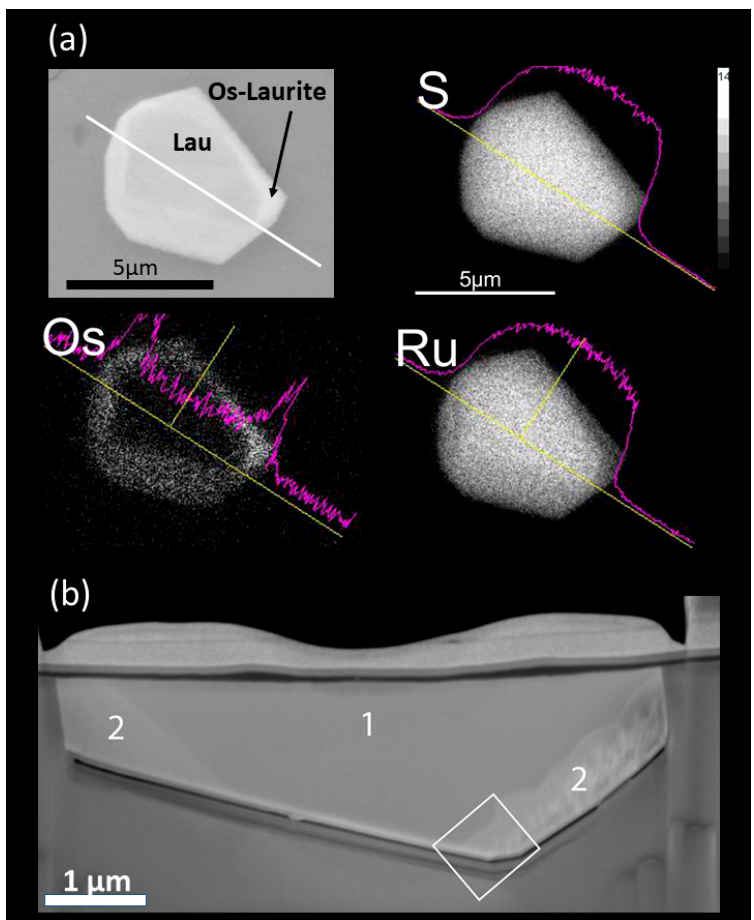
Figure 4. ( a ) Backscattered electron (BSE) images of euhedral normal zoned laurite (ARC-16/7 grain) with Os-rich core included within the chromite matrix. EDX elemental mapping and compositional profile obtained using SEM reveal for S, Os and Ru are also shown. ( b ) BSE images collected with FIB-SEM of the thin-foil extracted from the laurite ARC-16/7 grain. 1 (core zone) and 2 (rim zone) show different compositional zoning domains, white rectangle corresponds to the region of interest showing core-rim boundary.